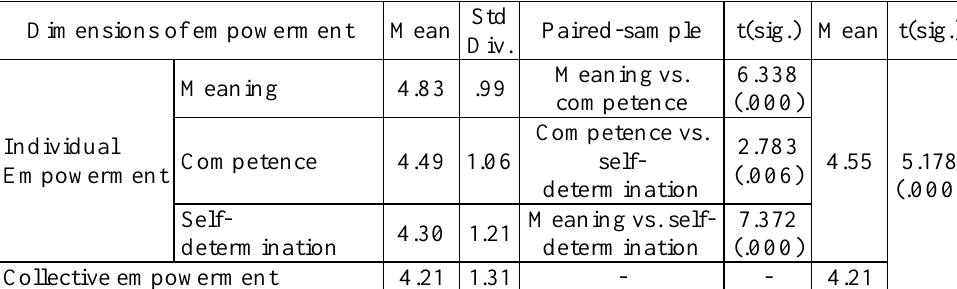
Table 3 Government Employees’ Individual and Collective Empowerment Dimensions of empowerment